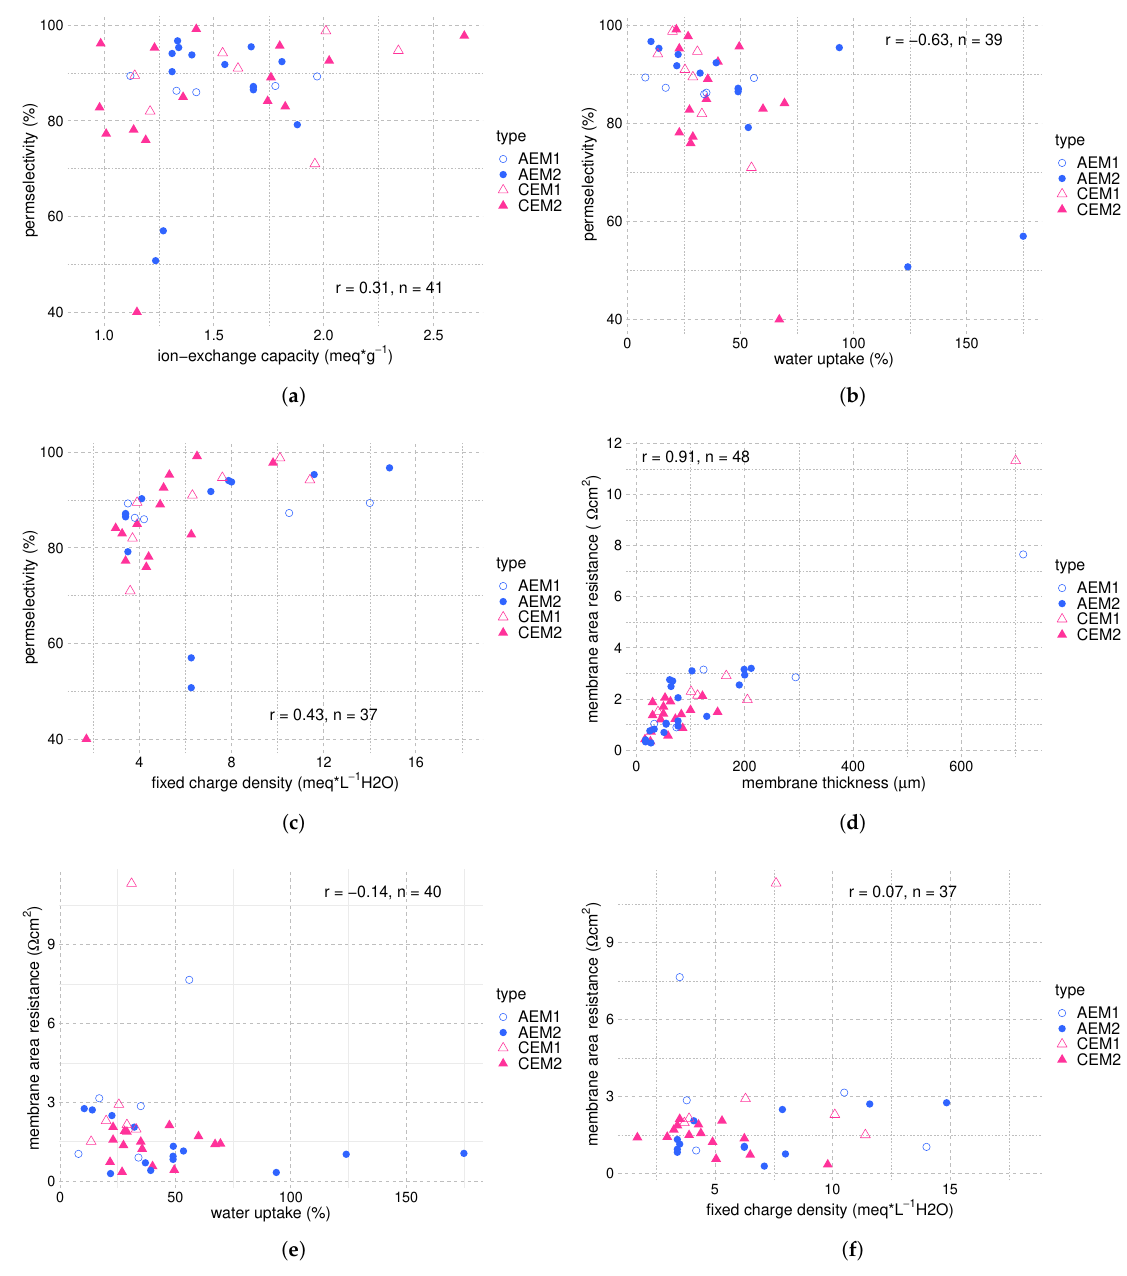
Figure 5. Membrane area resistance and permselectivity plotted against membrane thickness, IEC, water uptake, and FCD. Data are extracted from Tables 2 and 3, and were restricted to studies working with NaCl. Additional data concerning commercial membranes have been collected from [92,93,112]. A total of 81 observations form the basis of the analysis, with 21 observations of commercial AEMs (AEM1), 20 of tailor-made AEMs (AEM2), 23 of commercial CEMs (CEM1), and 17 of tailor-made CEMs (CEM2). The Pearson coefficient r indicates the correlation between the two plotted variables, and n refers to the number of observations used for each plot. ( a ) permselectivity vs. ion-exchange capacity, ( b ) permselectivity vs. water uptake, ( c ) permselectivity vs. fixed charge density, ( d ) membrane area resistance vs. membrane thickness, ( e ) membrane area resistance vs. water uptake, and ( f ) membrane area resistance vs. fixed charge